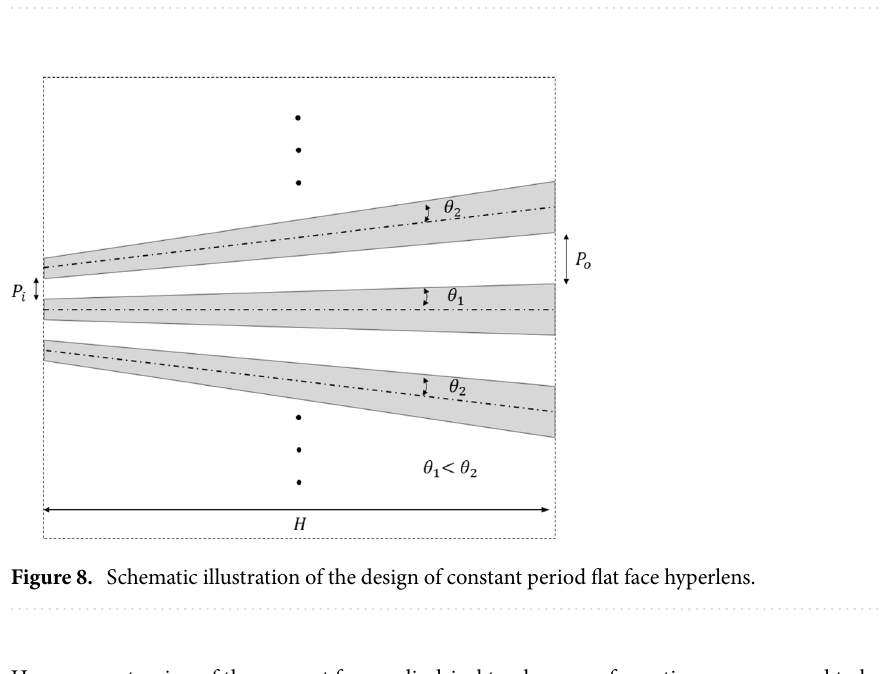
Figure 7. Dispersion curves for the cylindrical hyperlens composed of air and stainless steel fins with various filling fractions.